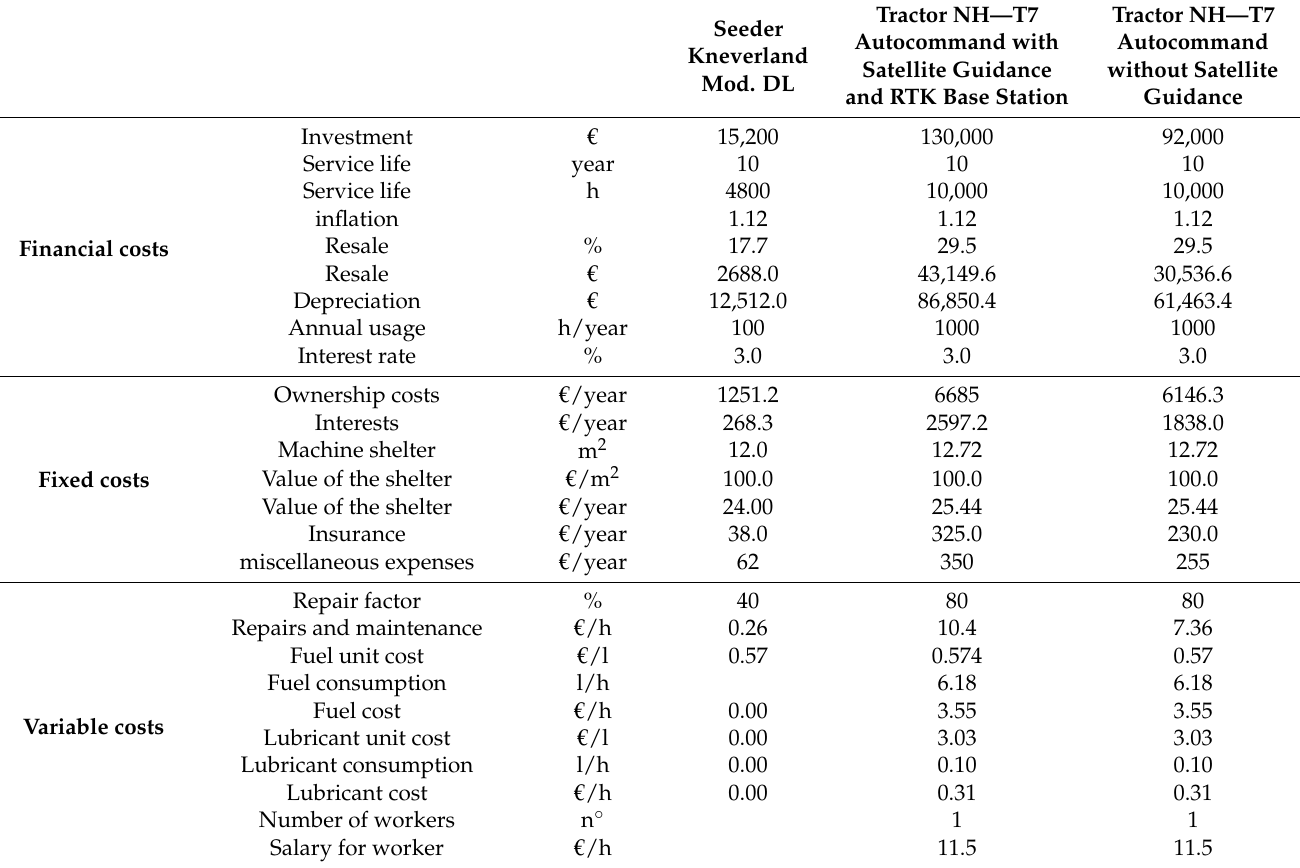
Table 1. Scheme of the parameters considered for the economic